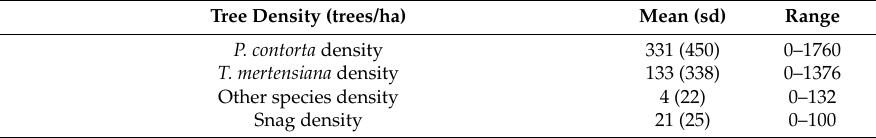
Table 1. Summary statistics of whitebark pine plots measured at Yosemite National Park, CA, USA ( n = 35). Seedlings were not sampled in one plot, reducing the sample size to 34. DBH = diameter